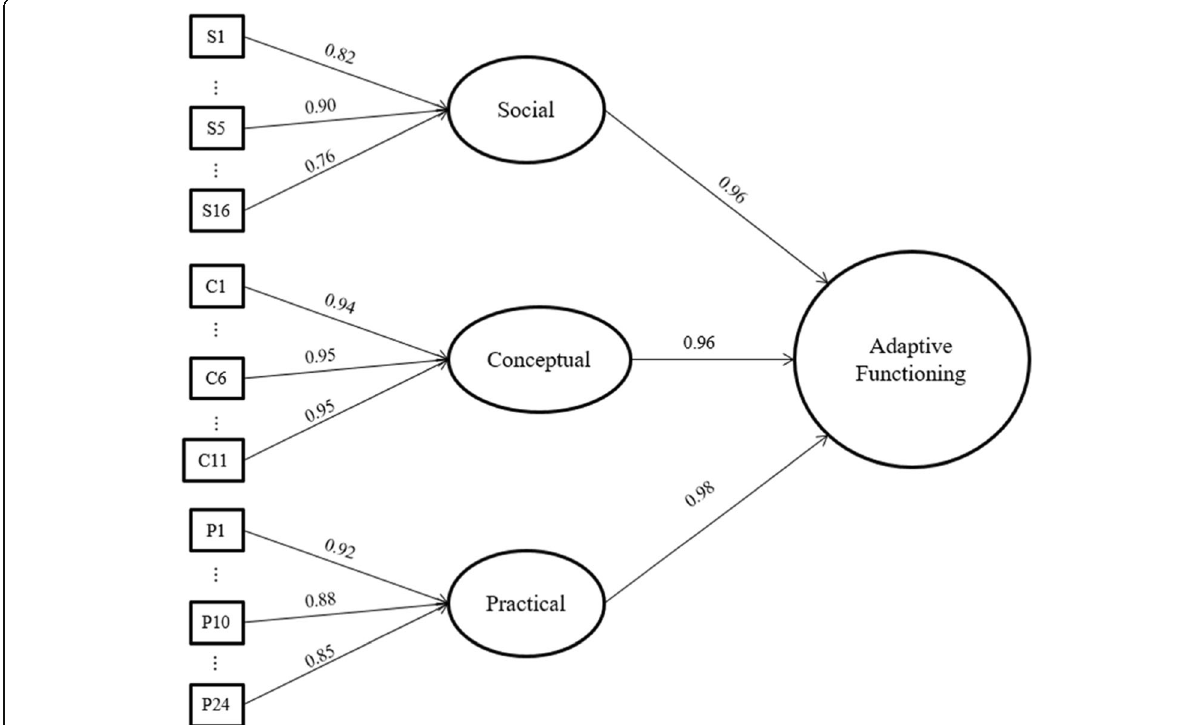
Fig. 1 Confirmatory model considering an overall factor of adaptive functioning. Note: Some items were omitted to facilitate visualization of the model; the specified factor loadings of all the items in the model are presented in Table